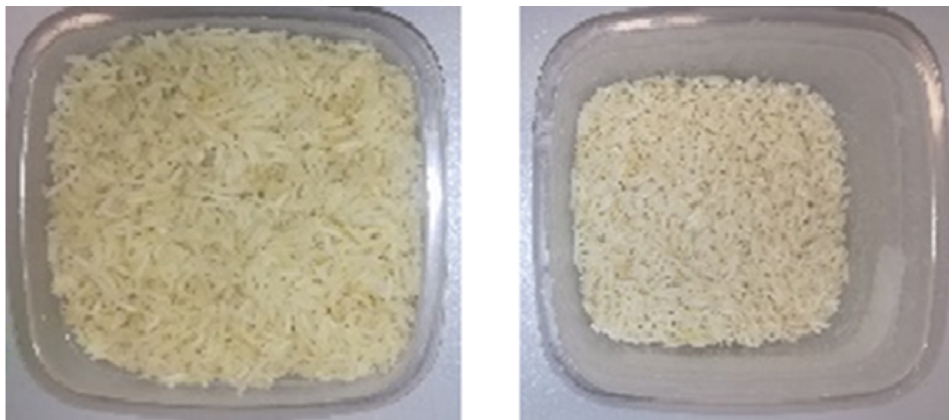
Figure 1. Local rice grains, long and short.